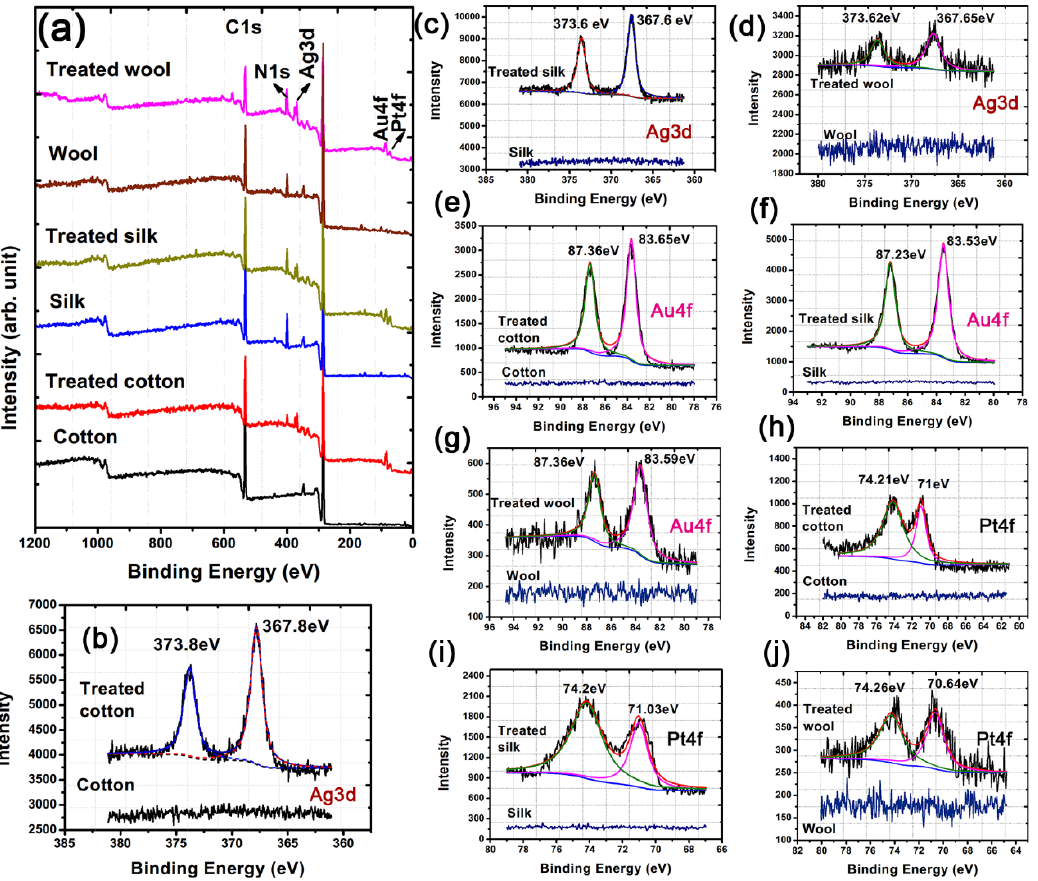
Figure 6. ( a ) Wide-scan, ( b – d ) Ag 3d, ( e – g ) Au 4f, and ( h – j ) Pt 4f XPS spectra of blank and treated cotton, silk, and wool textiles (NP content: approximately 5500 mg/g). Table 1. XPS peaks of the treated cotton, silk, and wool textiles.